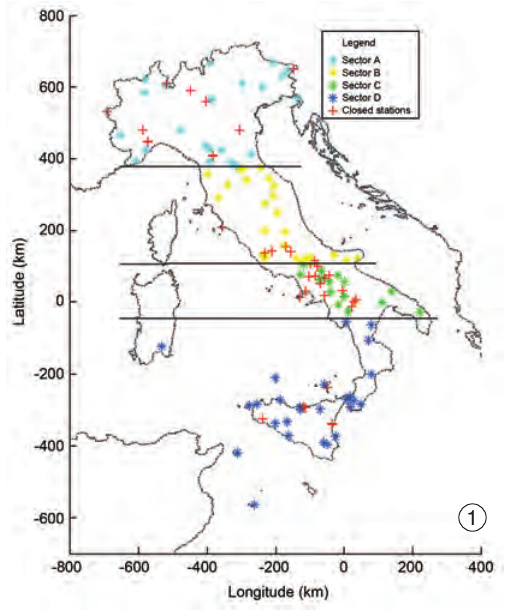
Fig. 1. INGV seismographic network configuration. The star symbols indicate the station locations, the red plus symbols the closed stations. The four colors of the stars are related to four sectors: north, center-north, center-south, south. Fig. 2. Evolution of the seismographic network du- ring the analyzed period. Colors of the stacked histo- grams are related to the years, the different amplitu- de of the columns is associated to the different per- 1 centage working that year. Stations are in descending order based on latitude, and the stations reported in the four histograms are indicated, in the previous fi- gure, by the four sectors respectively.